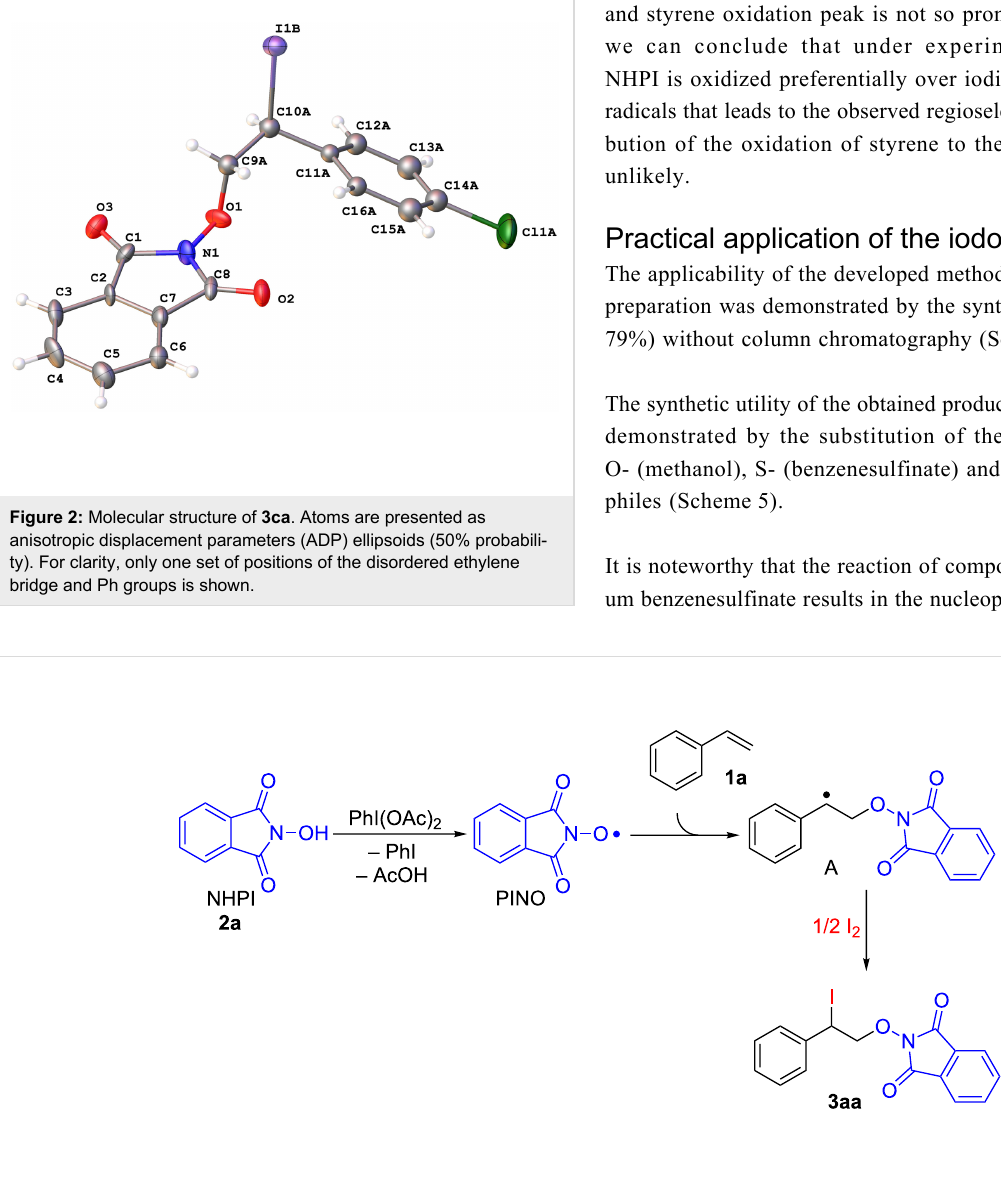
Scheme 3: The proposed mechanism of iodo-oxyimidation of styrene ( 1a ) using the NHPI/I 2 /PhI(OAc) 2 system with the formation of product 3aa .